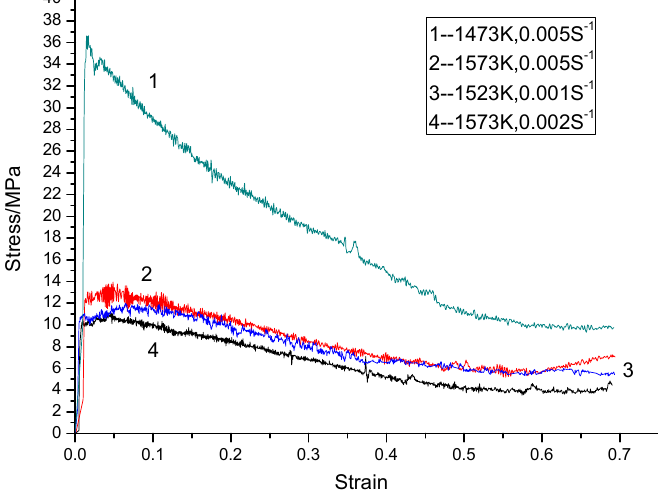
Figure 3. True stress-strain curves for the sintered Ti-22Al-25Nb alloy at different deformation temperatures and different strain rates.